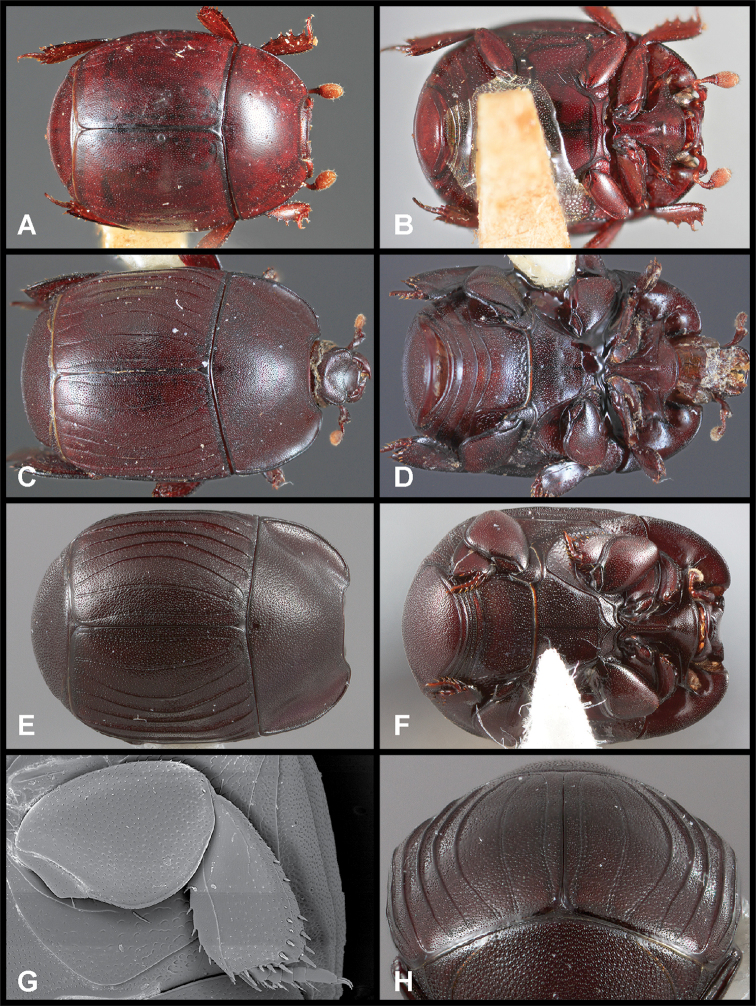
A, BPhelister
notandus: A dorsal habitus B ventral habitus C, DPhelister
amazoniae: C dorsal habitus D ventral habitus E–HP.
arcuatus: E dorsal habitus F ventral habitus G mesothoracic leg H posterior view showing carinate elytral striae.